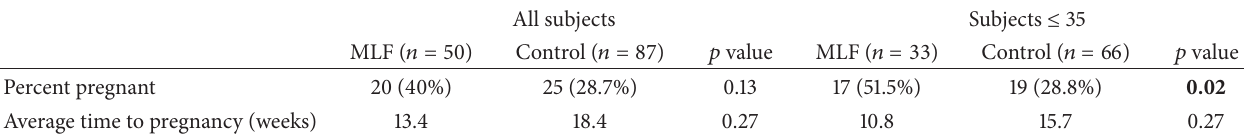
Table 2: Reproductive